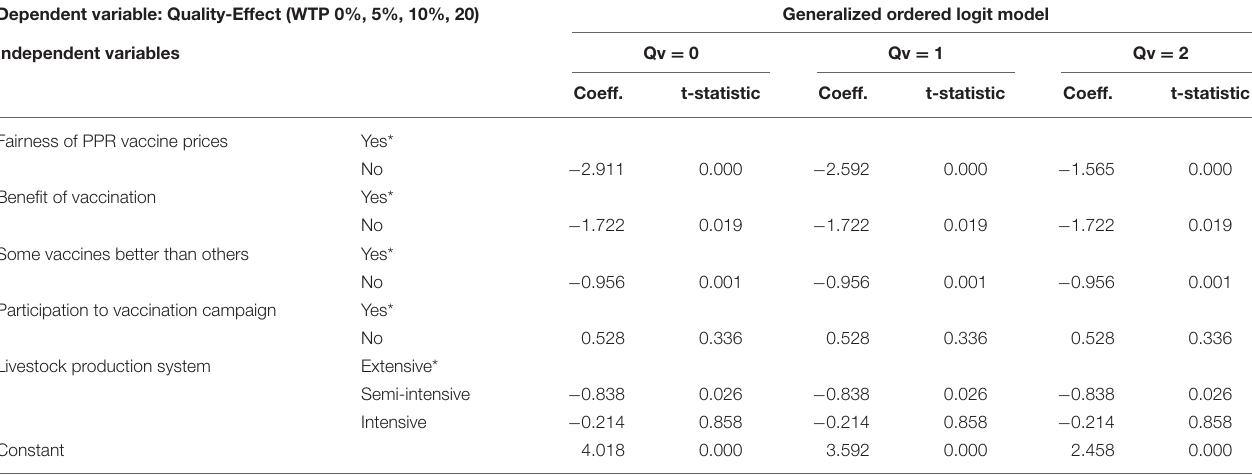
TABLE 9 | Regression analysis results for the quality-effect.